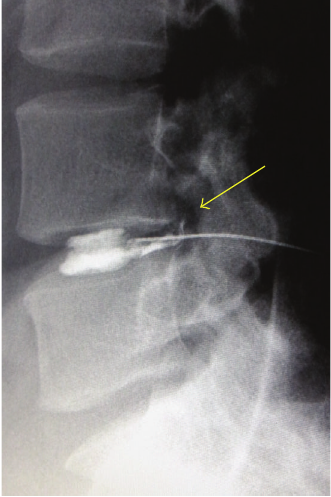
Figure 2: Discography findings showing leakage of contrast media into the annular tear. At this time, the patient reported concordant low back pain, which was completely relieved by intradiscal injec- tion.